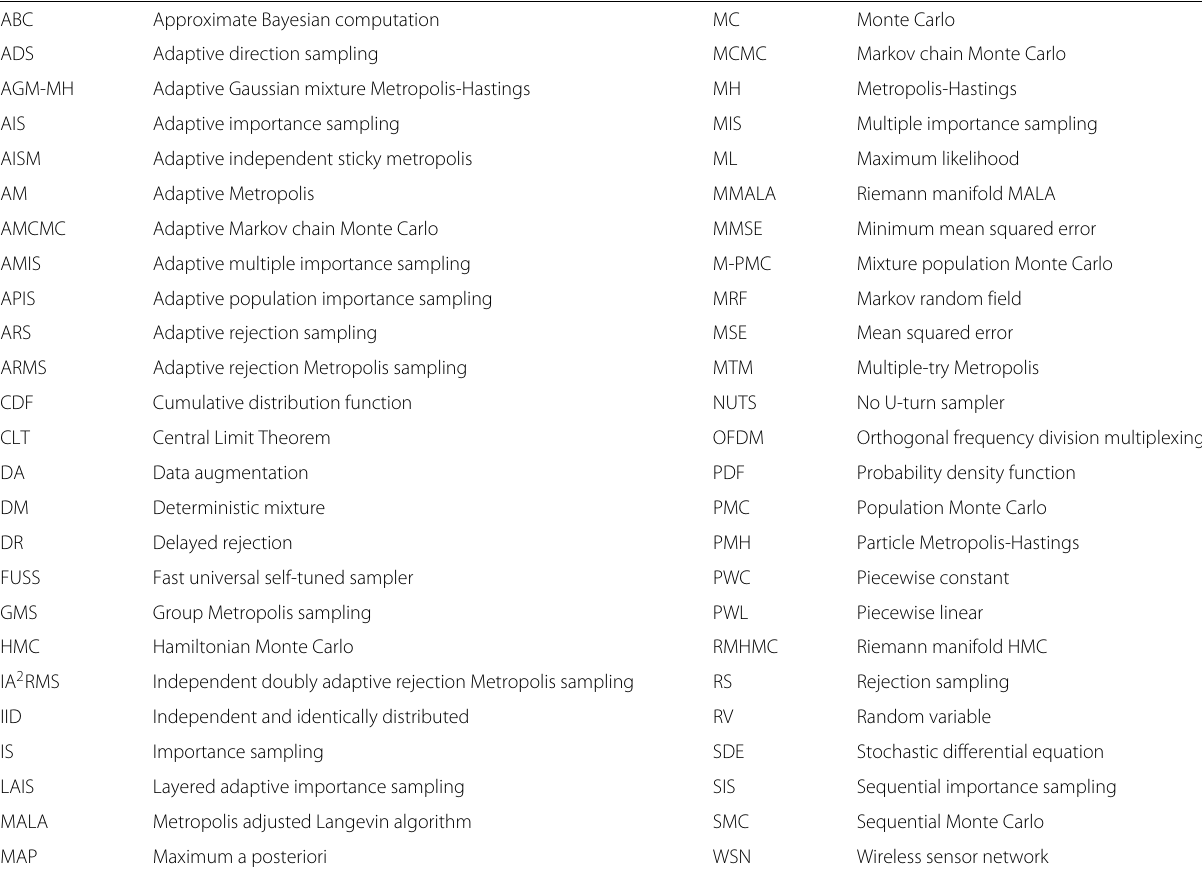
Table 1 List of acronyms